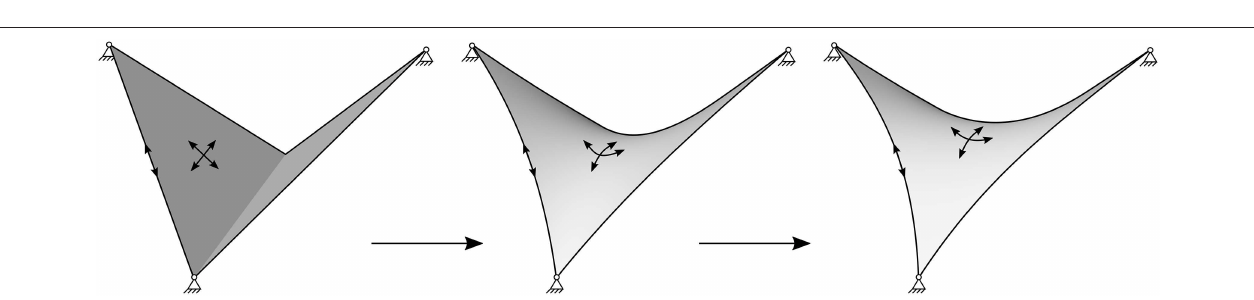
FIGURE 5 | Formfinding process for a hypar with Updated Reference Strategy from left to right: an arbitrary starting geometry is updated until an equilibrium surface is